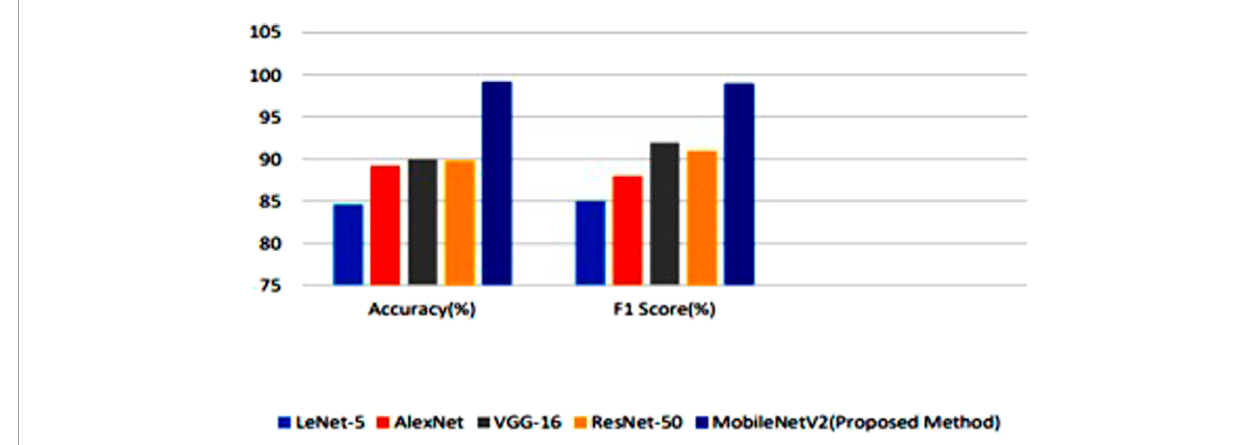
FIGURE 7 Comparative Analysis of proposed Face Mask detection system with various models.